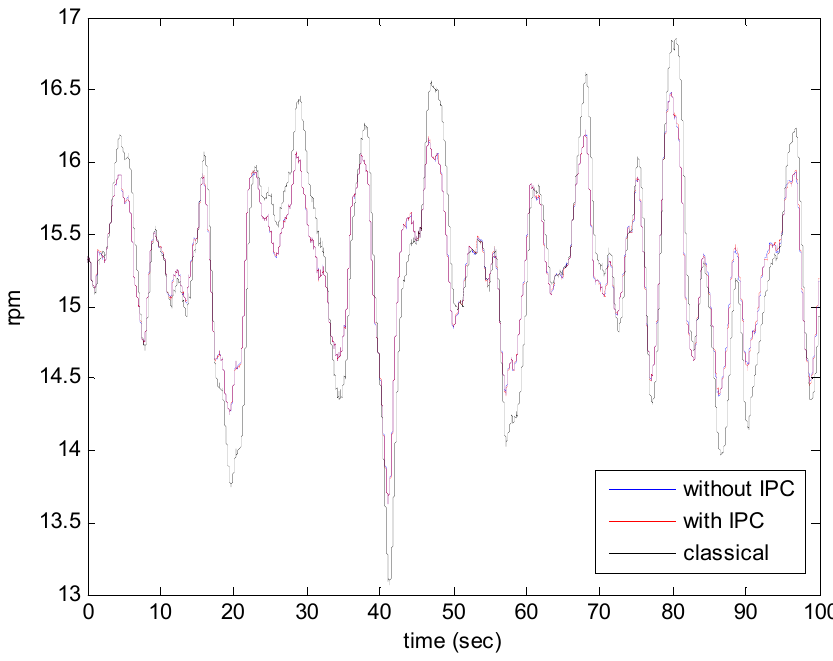
Figure 13. Responses of rotor speed.